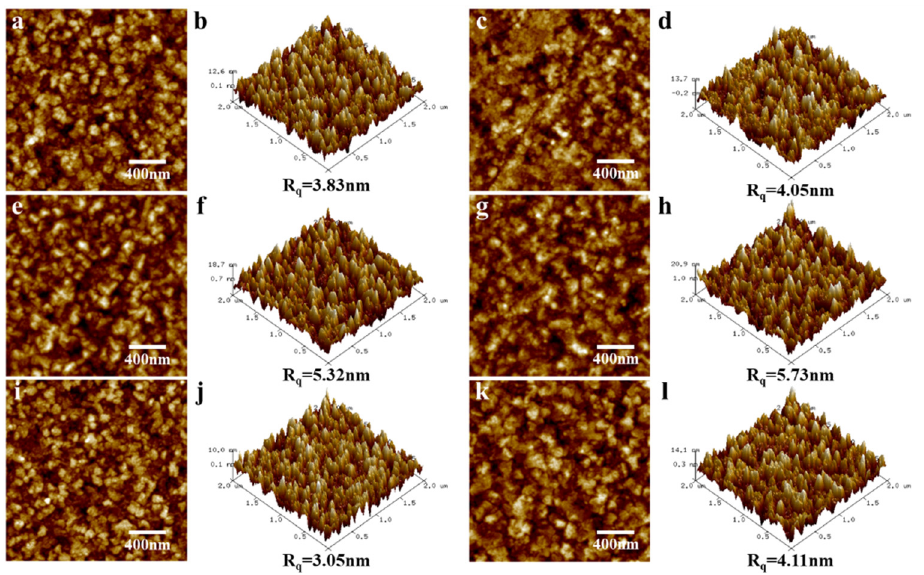
Figure 4. AFM pictures of In 2 O 3 :H thin-film samples at different annealing temperatures and times ( a , b ) 200 °C 1 h, ( c , d ) 200 °C 3 h, ( e , f ) 250 °C 1 h, ( g , h ) 250 °C 3 h, ( i , j ) 300 °C 1 h, ( k , l ) 300 °C 3 h.